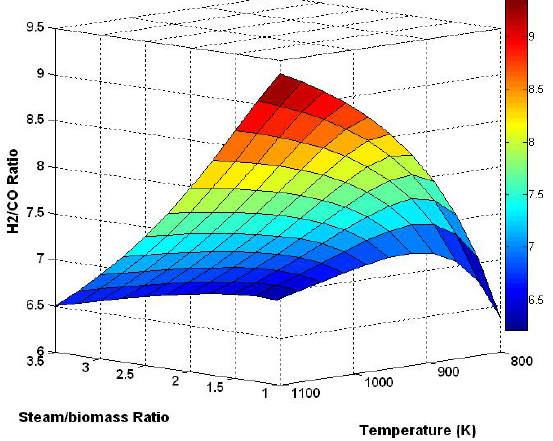
/CO for different temperatures and steam/biomass ratios. Figure 5. Surface plot of H 2